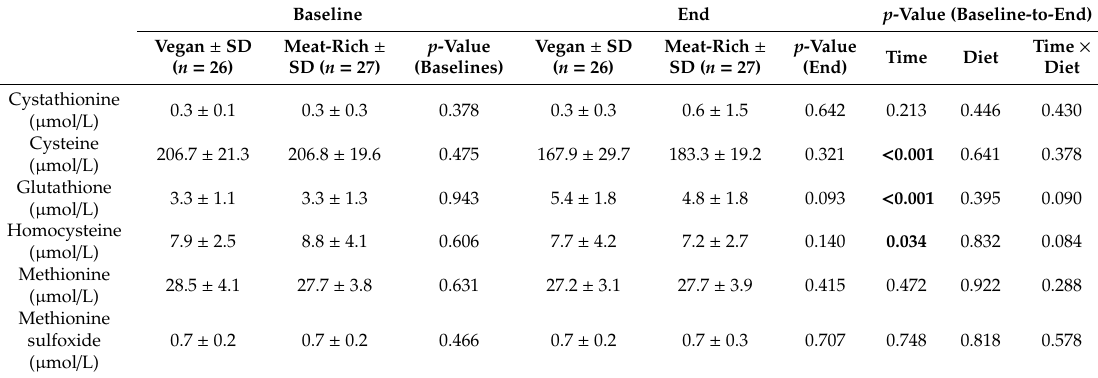
Figure 5. Cystathionine (Panel A ), cysteine (Panel B ), glutathione (Panel C ), homocysteine (Panel D ), methionine (Panel E ), and methionine sulfoxide (Panel F ) in plasma before and after 4-week dietary